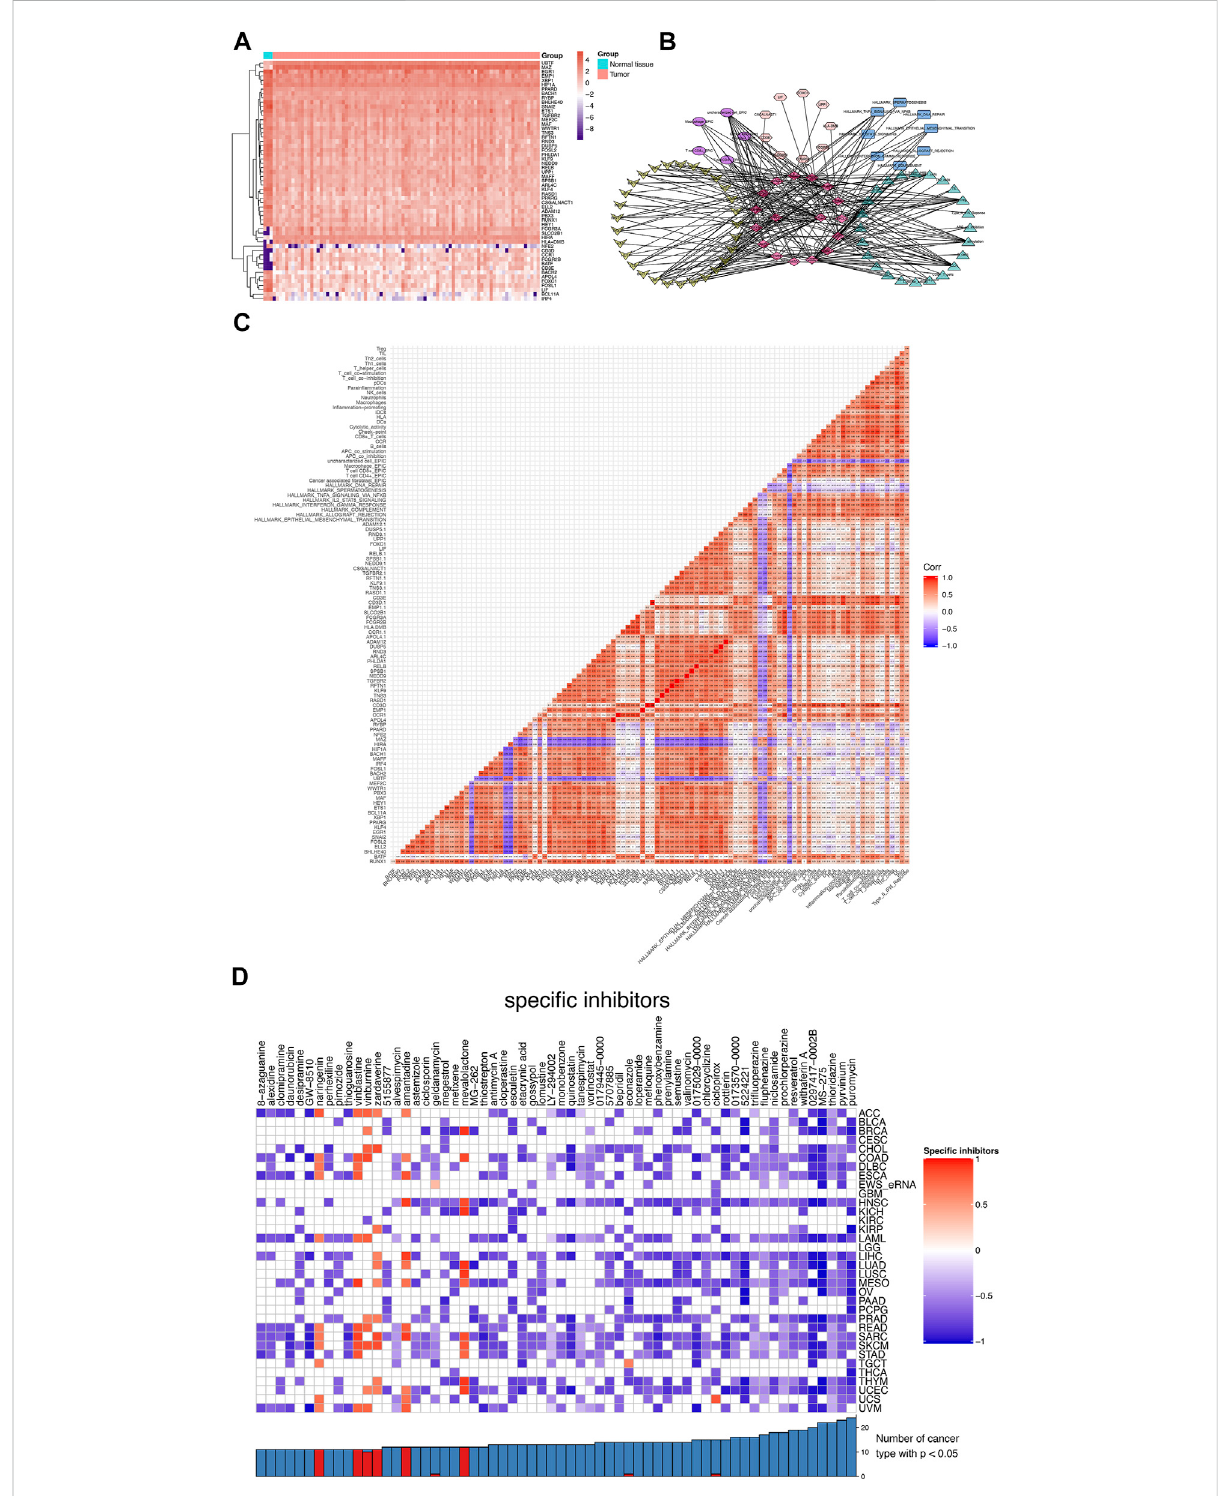
FIGURE 6 The network construction and Connectivity Map Analysis. (A) The heatmap of DEeRNAs, DETFs, and DETGs. (B) The six different dimension regulatory network, encompassing 17 DEeRNAs, 29 DETFs, 9 DETGs, 5 immune cells by CIBERSORT, 24 immune gene sets by ssGSEA, and 8 hallmarks of cancer by GSVA. (C) The cor-expression heatmap of these components above. (D) The CMap analysis of Ewing sarcoma as well as other 33 cancer